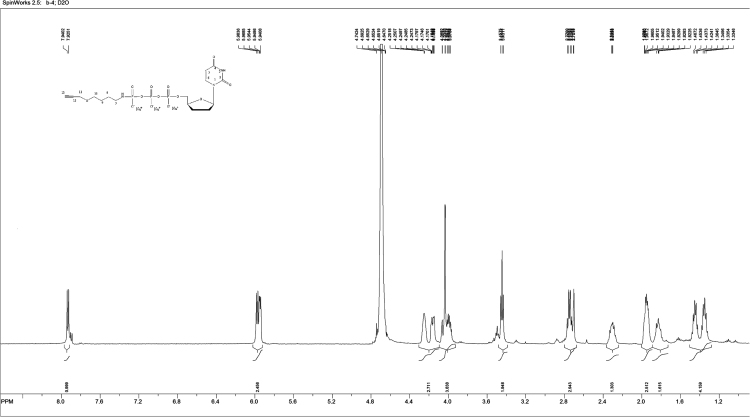
1H NMR spectrum of L~pppddU.